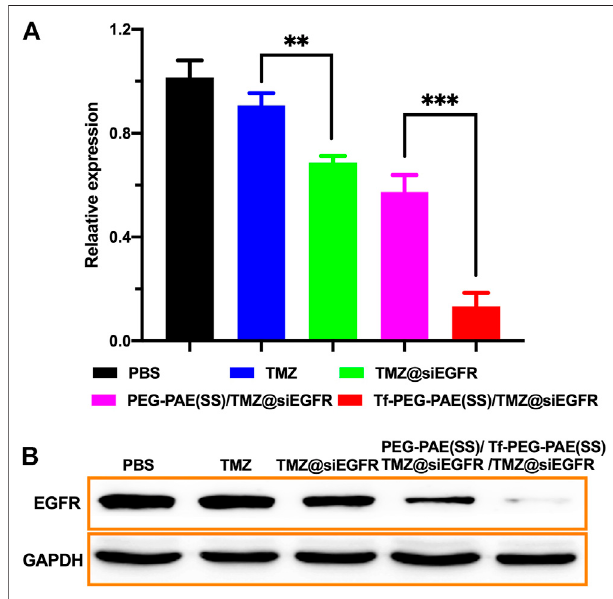
FIGURE 7 | In vitro gene silencing capability. (A) qRT-PCR analysis results of EGFR mRNA expression with different treatments. (B) Western blot